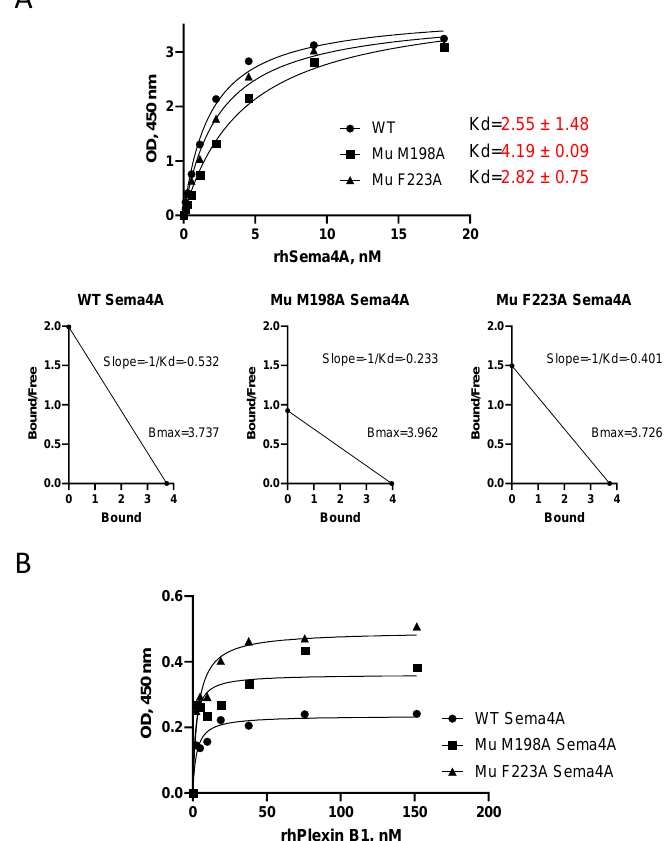
Figure 7. WT and Mutant (Mu) Sema4A proteins bind Plexin B1 with similar affinity. Direct ( A ) and reverse ( B ) LRA ELISAs for WT and Mu Sema4A protein binding to Plexin B1 were performed as described in Materials and Methods, analyzed in GraphPrizm 8.0 software, and corresponding Kd determination was performed as described for Figure 2. Kd are shown in mean ± SEM from three independent ELISA experiments, whereas slopes are from one representative experiment. The mutant proteins were tested for their stimulatory effect on Treg cells in PBMC cultures, as described previously [17]. As expected, WT Sema4A displayed a highly specific effect on Treg cells, as it increased the relative number of CD4+Foxp3+ cells among PBMCs from 3.96 ± 0.46% in cultures with medium only to 6.18 ± 0.58% in cultures with 100 ng of WT Sema4A (Figure 8A,C). At the same time, the M198A Sema4A mutant